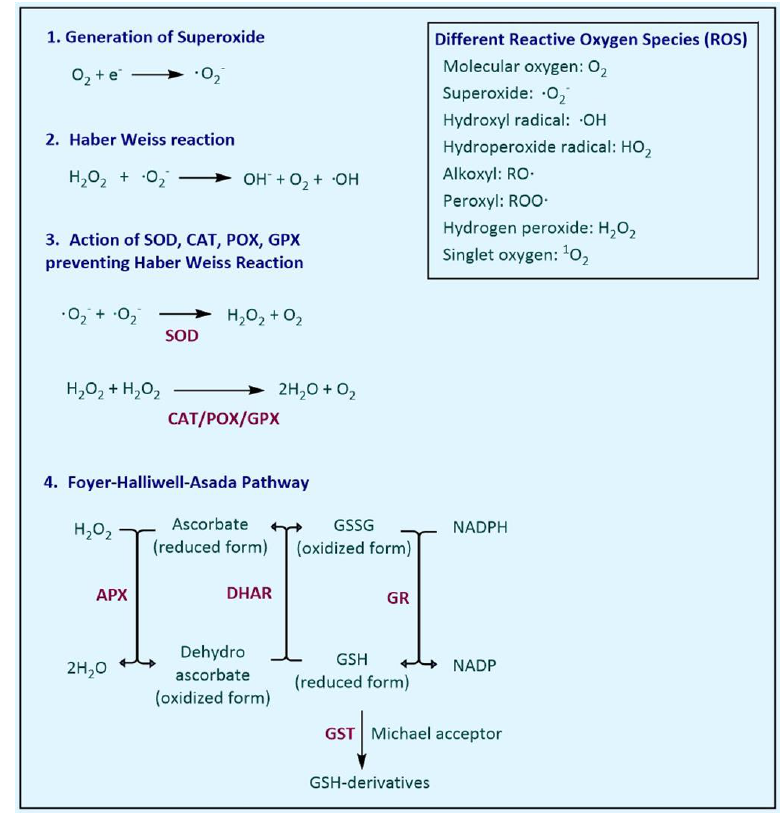
Figure 1. Basic reactions catalysed by the antioxidant enzyme system.